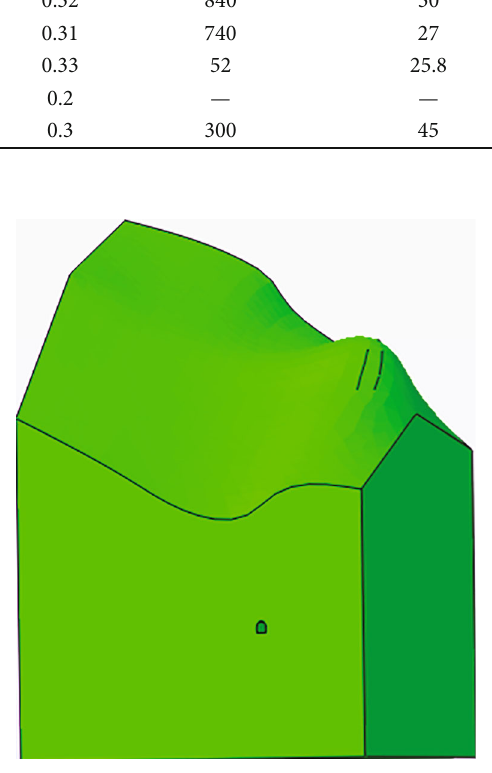
Figure 3: Mountain